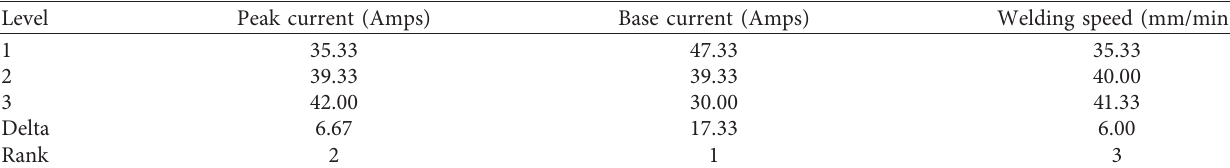
Figure 12: (a) Contour plot of impact peak current and base current. (b) Contour plot of impact base current and welding speed. (c) Contour plot of impact vs. welding speed and peak Table 14: Response table for means (hardness) (larger is better).